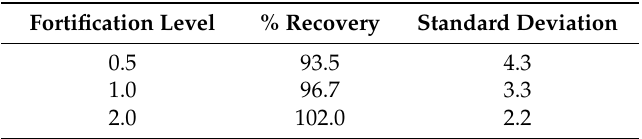
Table 2. Results of accuracy in three different fortification